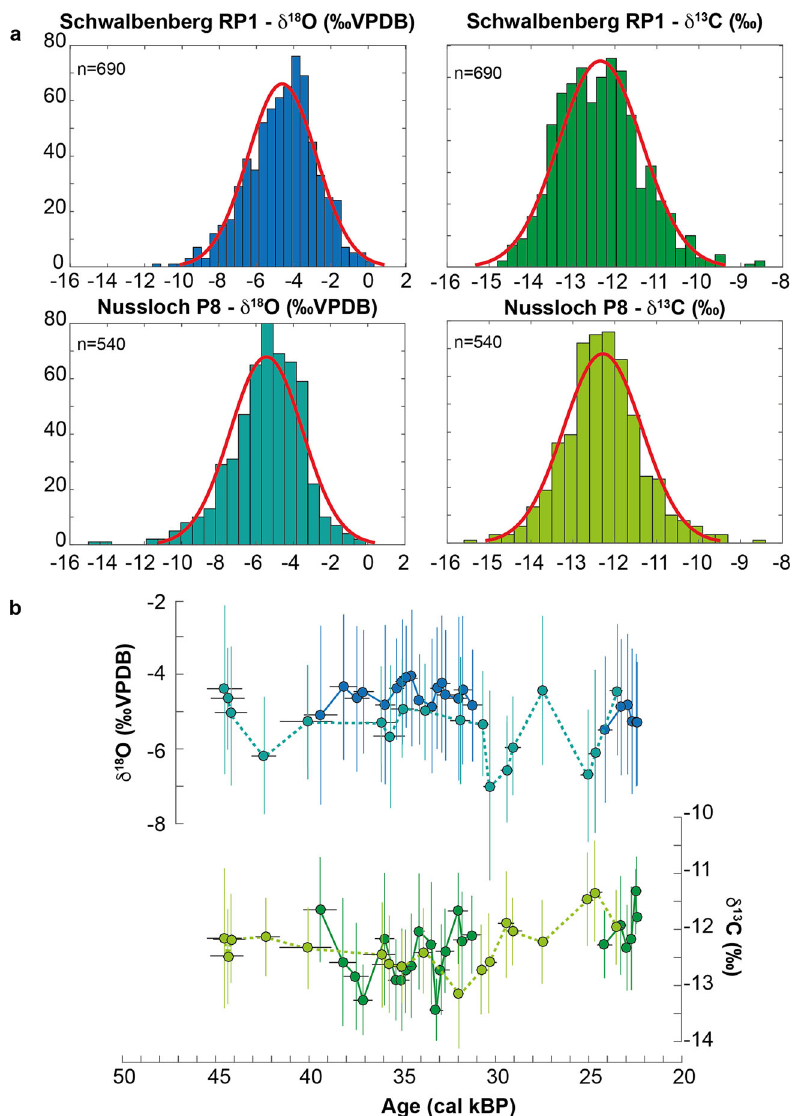
Fig. 4 Stable isotope composition of ECGs from Schwalbenberg and Nussloch. a Histogram of oxygen and carbon compositions for both sequences; b Schwalbenberg (dark-coloured plain lines) and Nussloch (light-coloured dotted lines) δ 13 C ( ‰ VPDB) and δ 18 O ( ‰ VPDB) values plotted against the Bayesian age-depth model of the radiocarbon dated sequence using IntCal20 (black horizontal error bars represent 95% con fi dence levels for modelled ages). Error bars on stable isotope values represent the standard deviation (1 σ ) of 30 individual measurements per sample of 5 cm